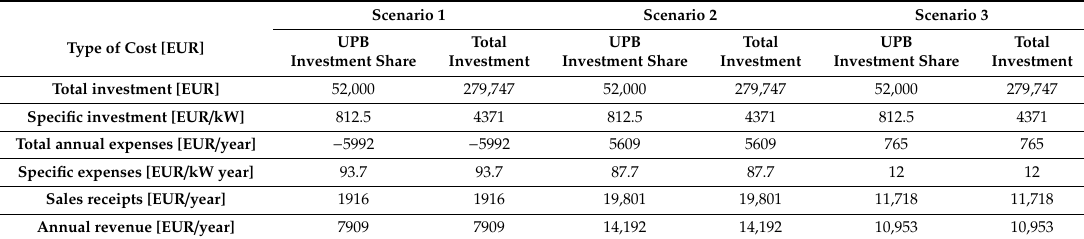
Table 2. Income and expenditure flows for the analysed scenarios.